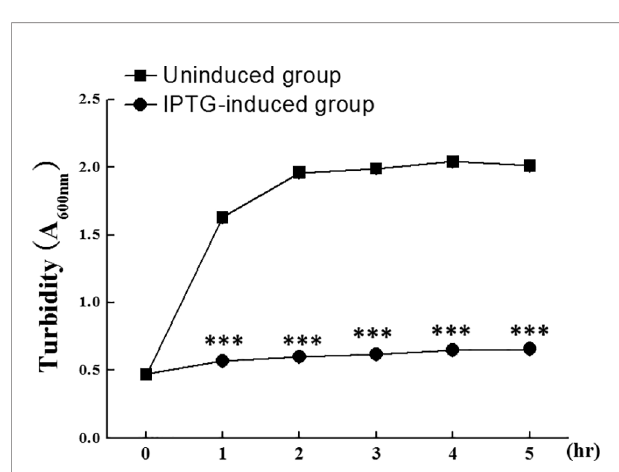
FIGURE 8 | The effect of r sl PGRP2 in bacterial growth. Recombinant sl PGRP2 (r sl PGRP2) was induced by the addition of IPTG. The potential effect of r sl PGRP2 in bacterial growth was analyzed by growth rate of E. coli using turbidity assay (spectrophotometer absorbance at 600 nm). E.coli carrying an IPTG-inducible slVasa expression cassette were used as reference control to show that the vector did not negatively affect E. coli growth. Samples were collected at 1-hr intervals after IPTG addition in IPTG- induced group. E.coli without IPTG treatment (uninduced group) was used as a reference. The three asterisks indicate Student ’ s t-test ( P <